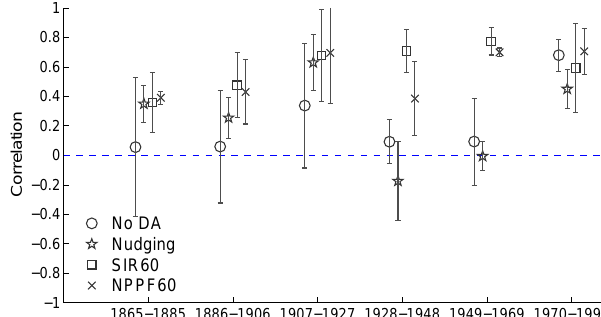
Fig. 11. Same as Figure 8, but for sea surface salinity.